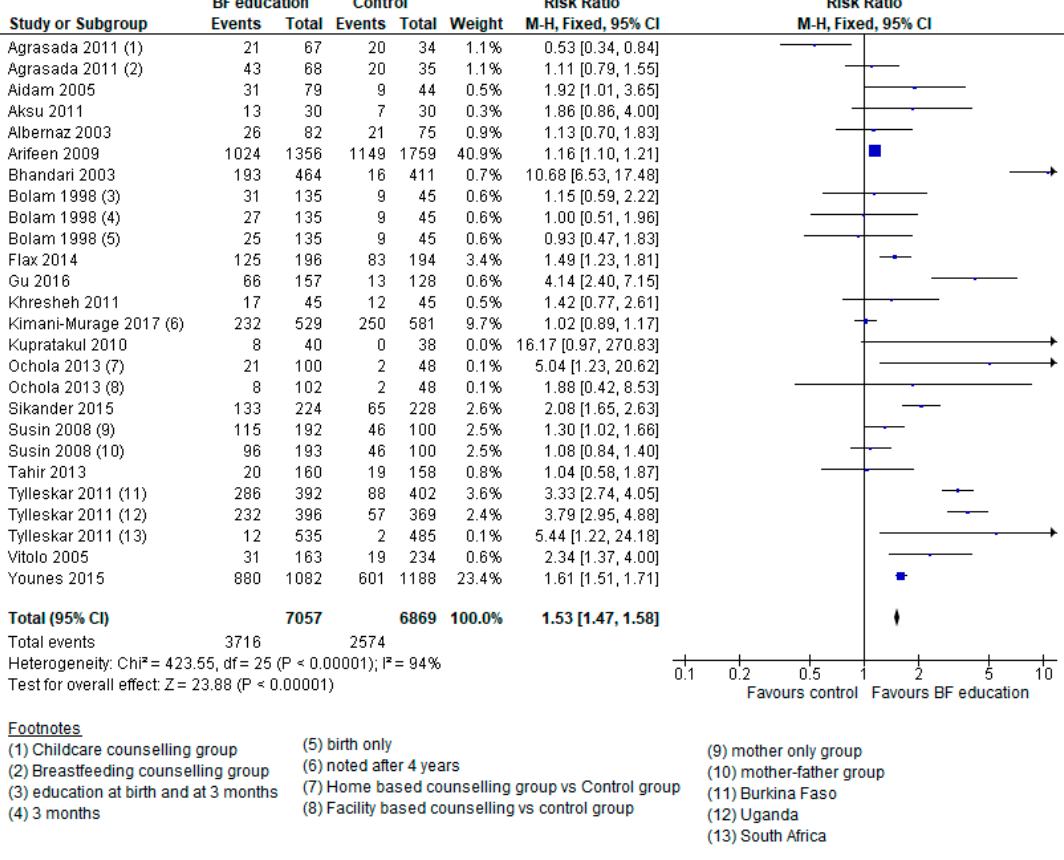
Figure 3. Forest plot displaying the meta-analysis of studies reporting on the effect of breastfeeding education interventions of the rate of exclusive breastfeeding at six months.